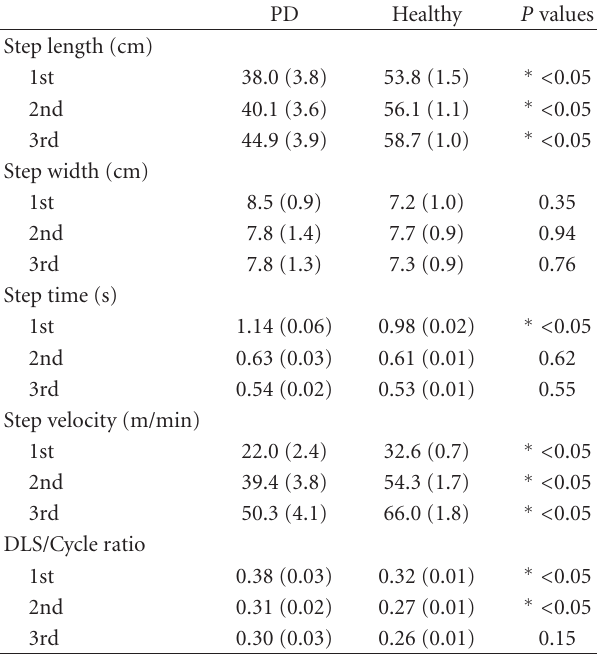
Table 2: Spatiotemporal